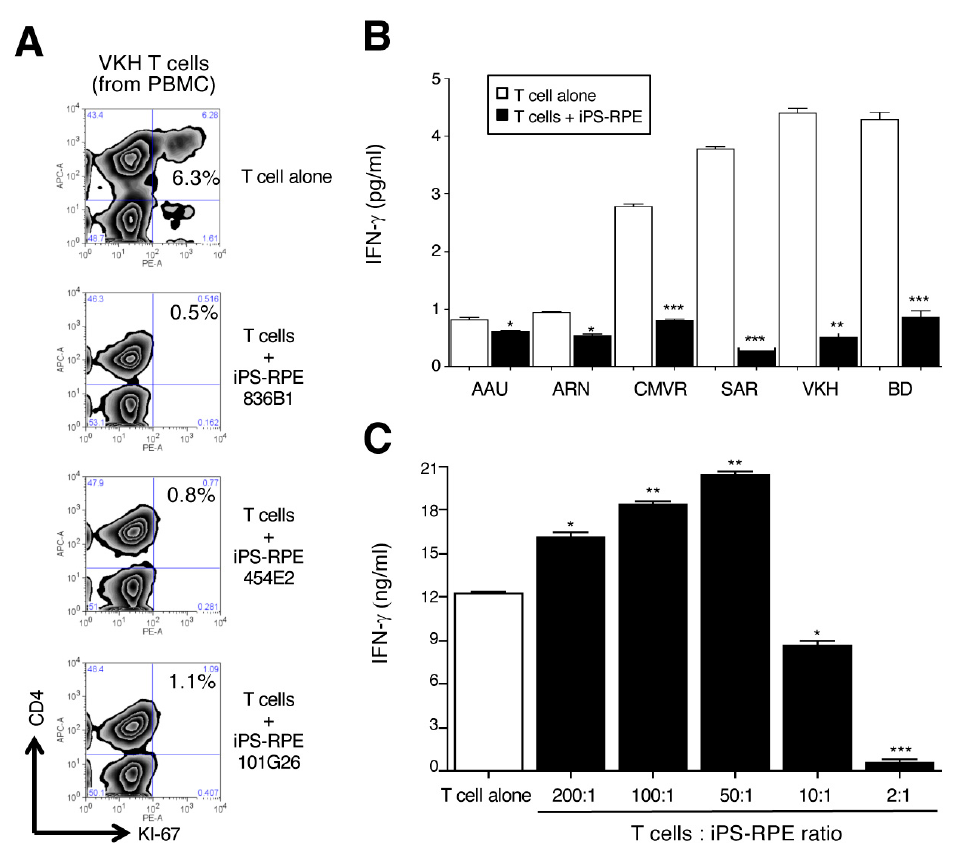
Figure 1. Capacity of iPS-derived RPE to suppress or stimulate uveitis T cells in vitro. ( A ) Three lines of established human iPS-RPE cells were used (836B1, 454E2, and 101G26) for the in vitro assays. Uveitis T cells were established from PBMC of a VKH disease patient with active uveitis. The proliferation of CD4 + T cells in VKH PBMC in the presence of iPS-RPE cells was evaluated by FACS analysis (CD4 and Ki-67 staining). PBMC were cocultured with to 5 × 10 5 (T cell:RPE ratio = 2:1) iPS-RPE cells. Numbers in the histograms indicate the percentage of cells double-positive for CD4 and Ki-67. ( B ) Data of IFN- γ -production in supernatants from Th1-type CD4 + uveitis T cells + iPS-RPE cells. T cells were cocultured with to 5 × 10 5 (T cell:RPE ratio = 2:1) iPS-RPE cells. Open bars indicate T cells alone, and black bars indicate T cells plus iPS-RPE cells. AAU: HLA-B27 associated acute anterior uveitis; ARN: acute retinal necrosis; CMVR: CMV retinitis; SAR: sarcoidosis; VKH: Vogt-Koyanagi-Harada disease; BD - Behçet’s disease. Data are the means ± SEM of three ELISA determinations. ( C ) Capacity of iPS-RPE cells to suppress the activation of bystander T cells in a T-cell number assay. In the presence of antihuman CD3 agonistic antibody and rIL-2, purified CD4 + T cells from PBMC of active uveitis patients with VKH disease were cocultured with 5 × 10 3 to 5 × 10 5 (T cell:RPE ratio = 200:1, 100:1, 50:1, 10:1, or 2:1) iPS-RPE cells (454E2) for 48 h. Results indicate the IFN- γ production by T cells exposed to iPS-RPE cells. Data are the means SEM of 3 ELISA determinations. * p < 0.05, ** p < 0.005, *** p < 0.0005, as compared to the positive control (T cells alone: open